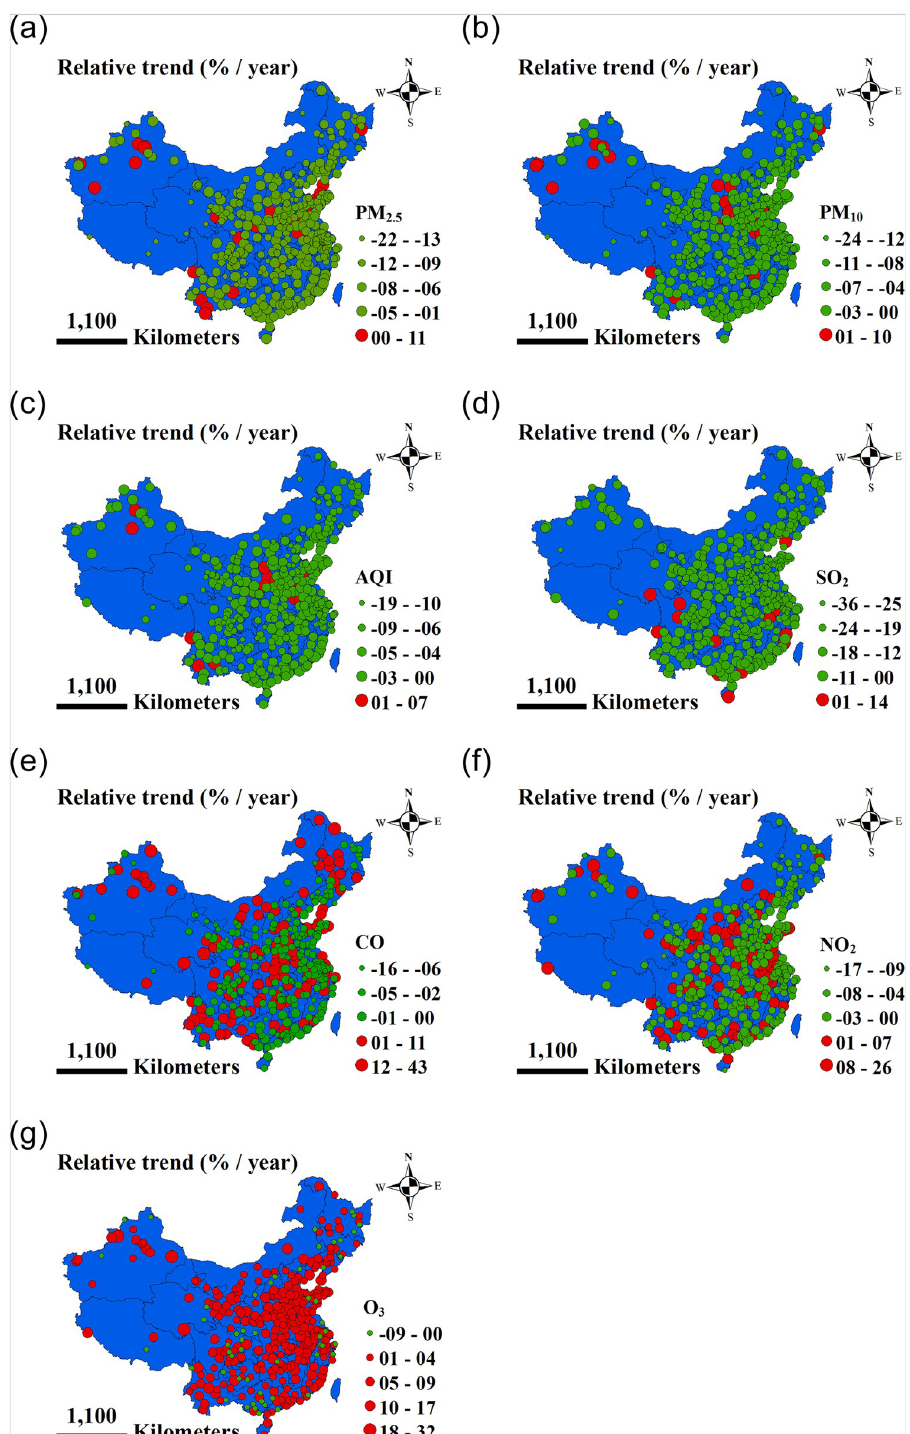
Fig 1. Sign of the annual average relative change (trend, %) from 2015 to 2019 (green: Significantly negative, and red: Significantly positive).